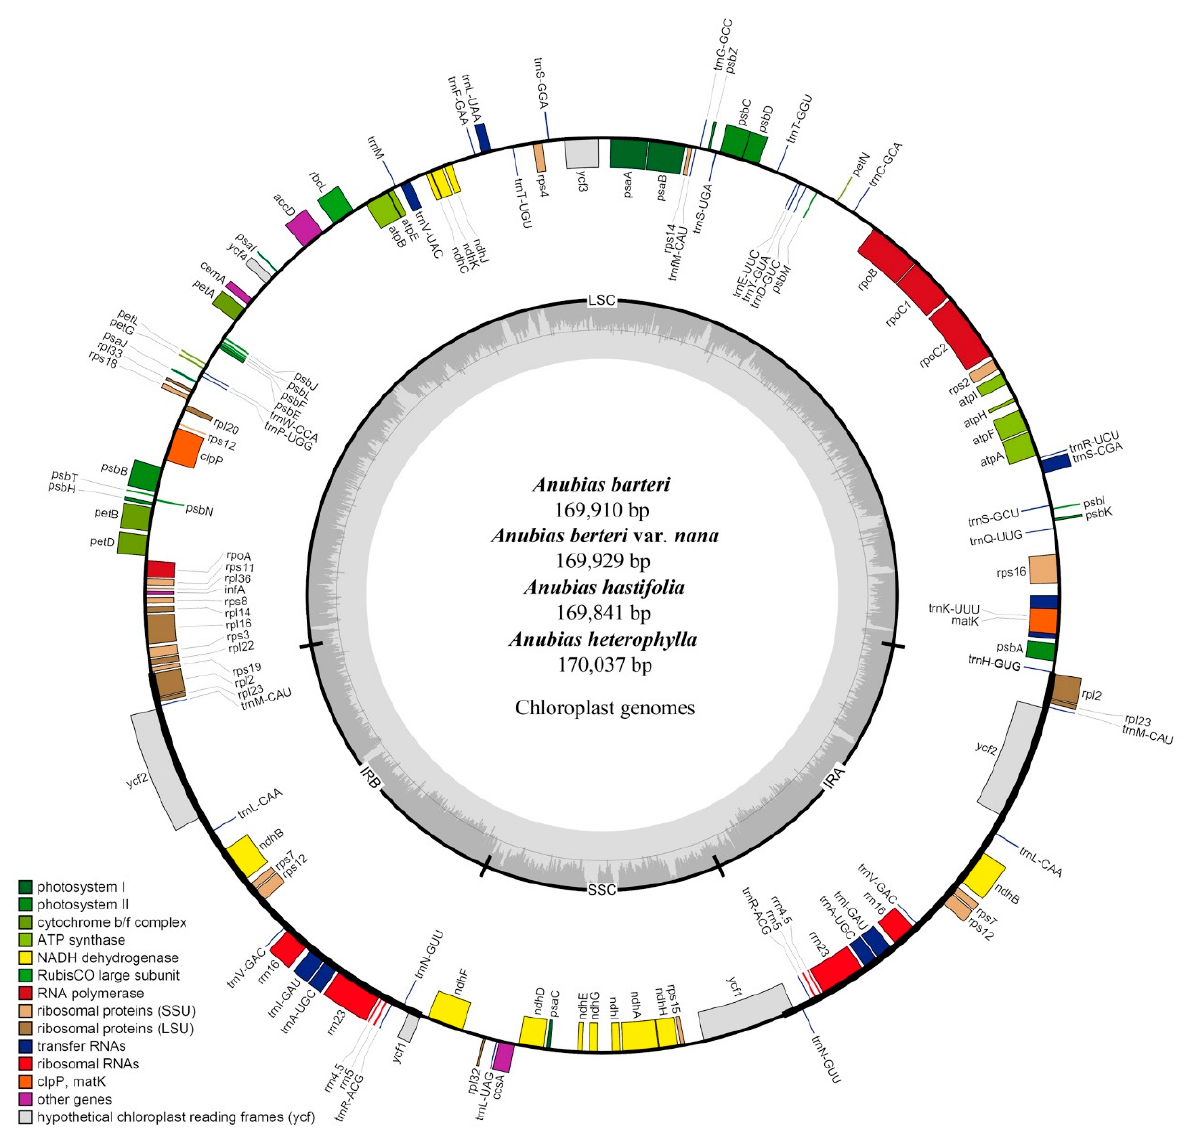
Figure 1. Circular map of chloroplast genomes of four Anubias plants. Genes shown inside of the inside layer circle are transcribed clockwise, whereas those genes outside of this circle are transcribed counterclockwise. The colored bars indicate the known protein-coding genes, tRNA, and rRNA. The darker gray area of the inner circle denotes the GC content, while the lighter gray area indicates the AT content of the genome. LSC, large single-copy; SSC, small single-copy; IR, inverted repeat.